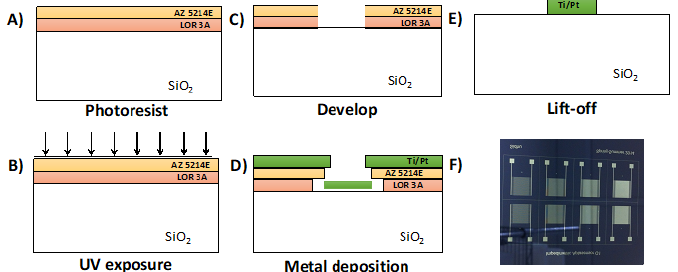
Figure 1. Microfabrication process for platinum interdigitated microelectrodes (Pt-IME) on SiO 2 wafers. ( A ) Photoresist deposition, ( B ) UV exposure with IME mask, ( C ) Development of resist, ( D ) Ti / Pt deposition by chemical vapor deposition (CVD), and ( E ) Pattern lift o ff . ( F ) Photographs of Pt-IME array with eight